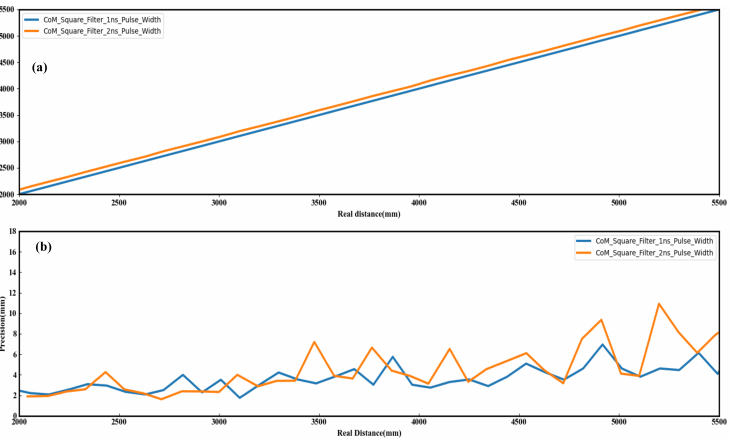
Figure 9. The results of 200 measurements with different laser pulse widths: ( a ) Mean distance. ( b ) Standard